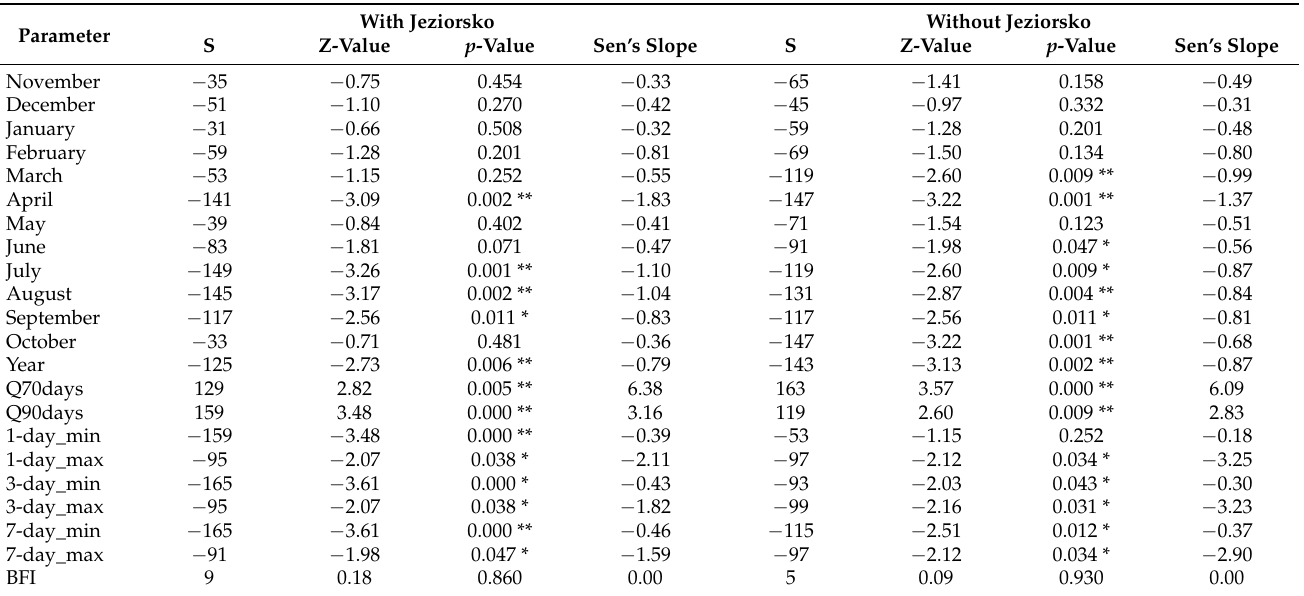
Table 2. Results of trend analyses for water flows at the Uniej ó w hydrological station with and without the Jeziorsko dam